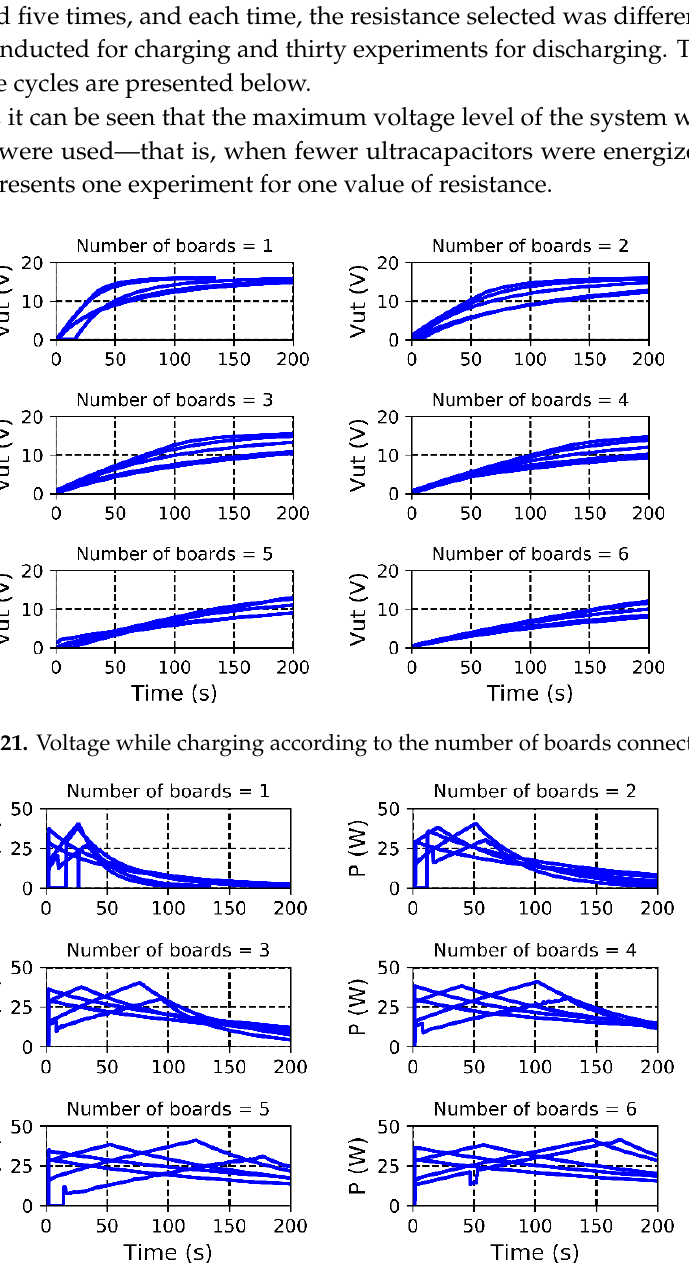
Figure 22. Power while charging according to the number of boards connected.